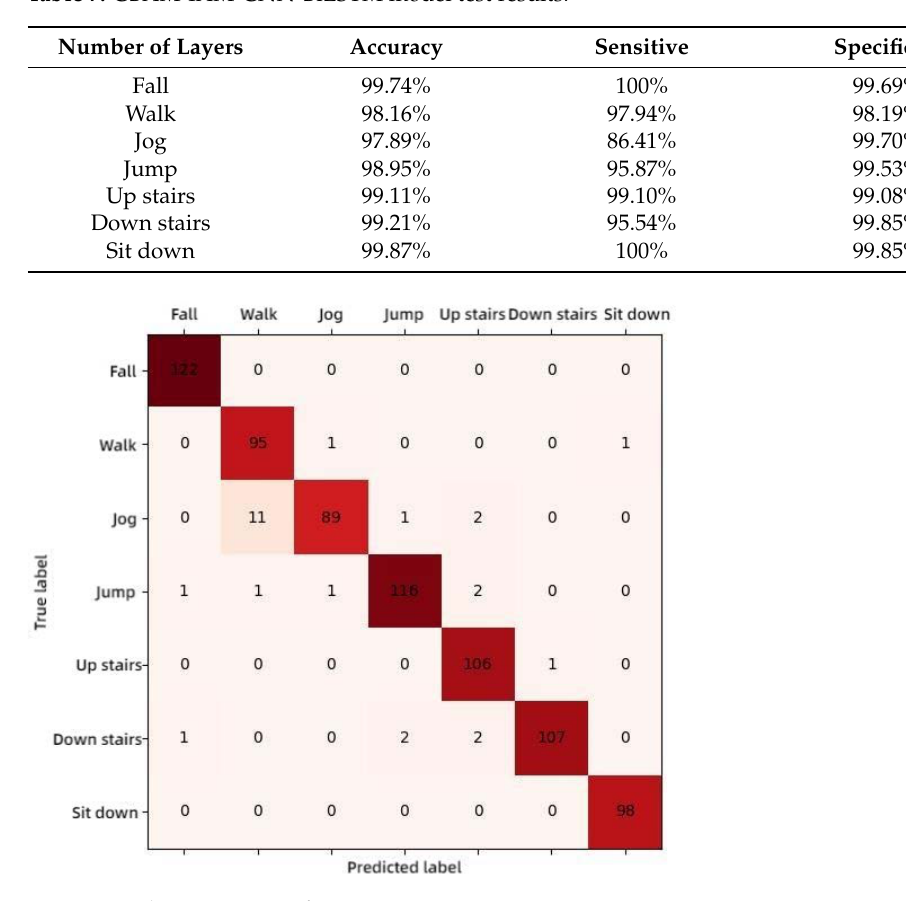
Table 7. CBAM-IAM-CNN-BiLSTM model test results.